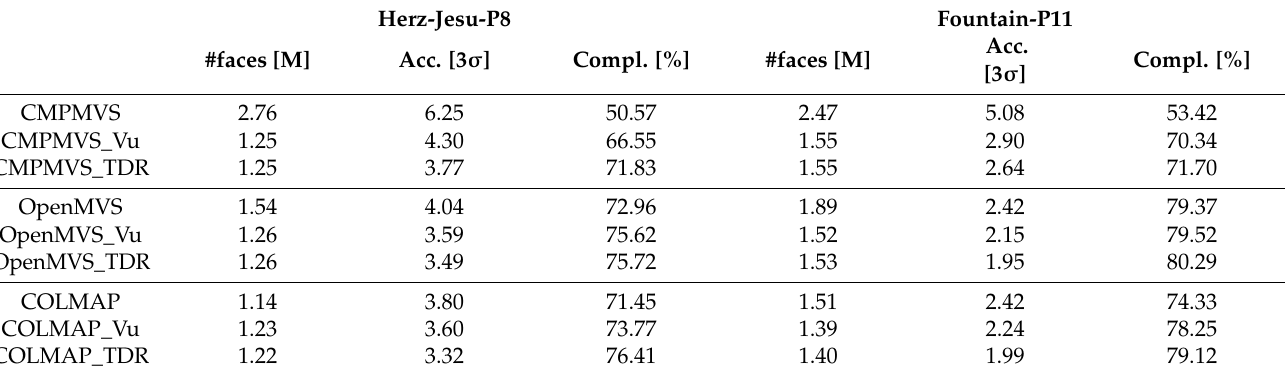
Figure 12. The residual occupancy density maps ( a – f ) and occupancy distribution histograms ( g , h ) of all meshes. Table 4. The accuracy and completeness of all meshes.